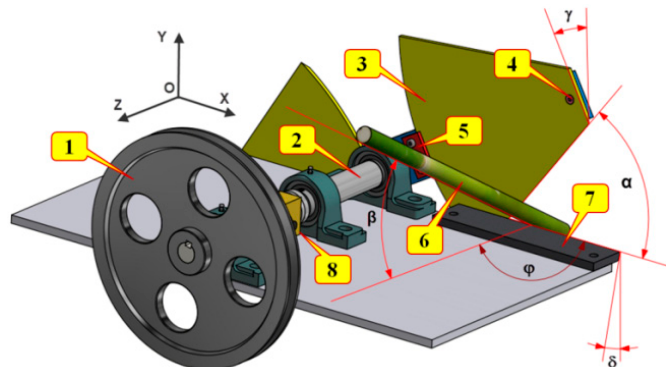
Figure 1. A 3D model of the experimental setup. (1) belt wheel; (2) spindle shaft; (3) knife; (4) screw; (5) clamp; (6) maize stalk; (7) counter shear; (8) torque sensor.